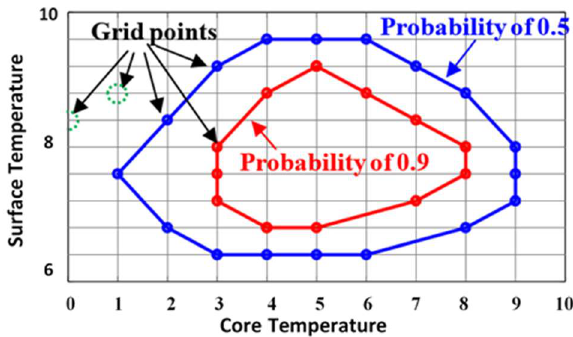
Figure 3. Schematic of joint confidence regions (JCRs) with different probabilities. Note that the units of temperatures in this work is Celsius degree ( ◦ C).